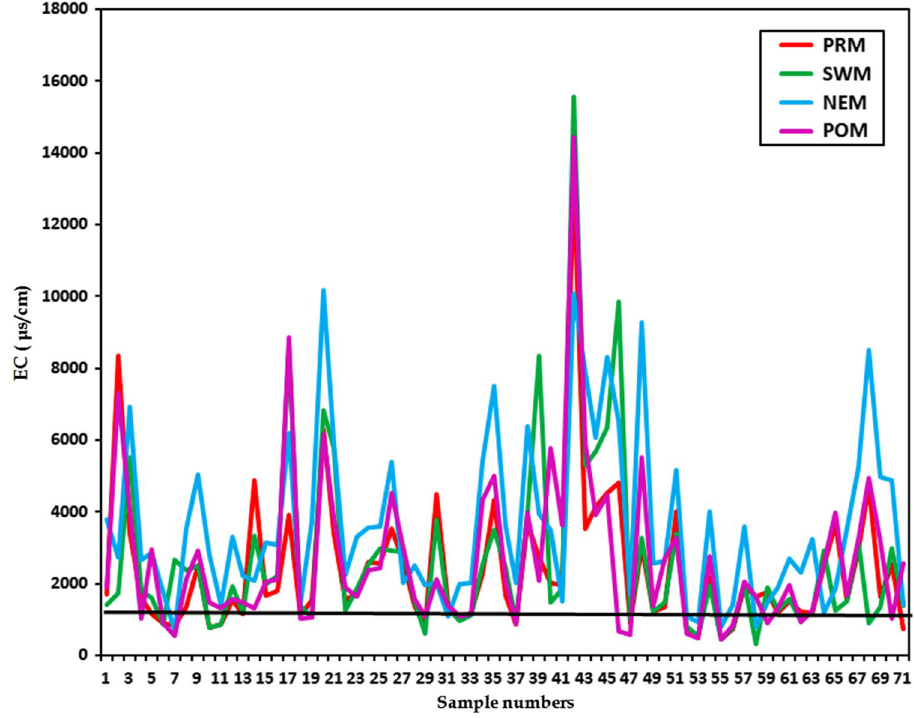
Fig. 4 EC classification based on Richards (1954) irrespective of seasons